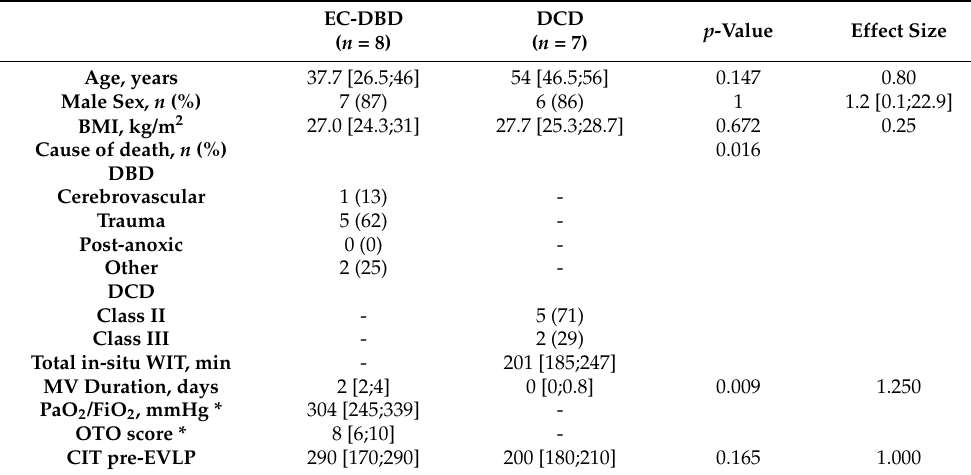
Table 2. Donor characteristics.